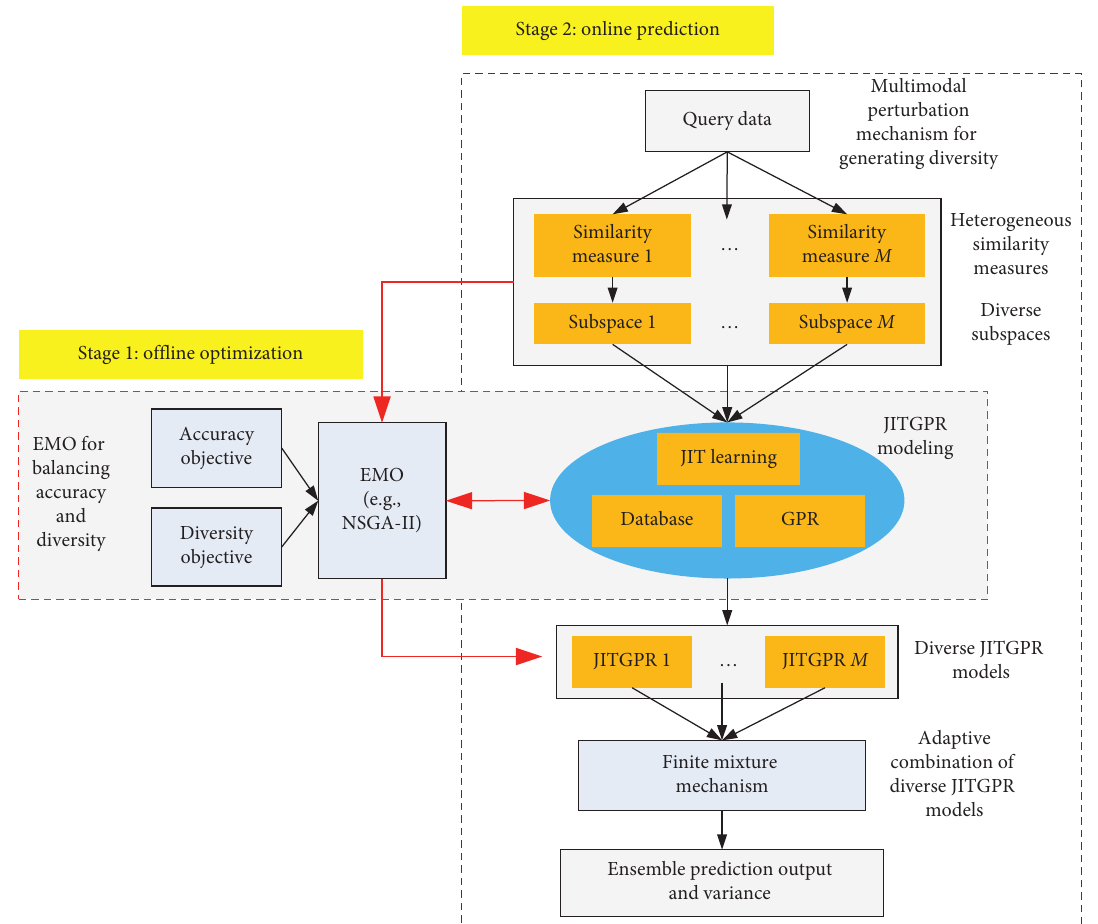
Figure 2: Schematic diagram of the proposed MP-EJITGPR soft sensing